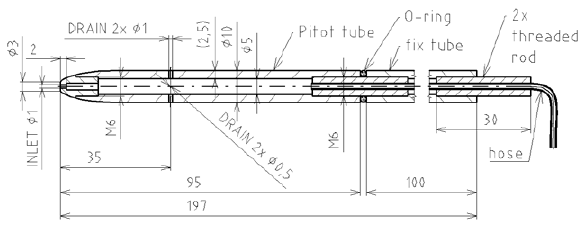
Reference Pitot –static tube Pitot tube with drain hole Wind tunnel